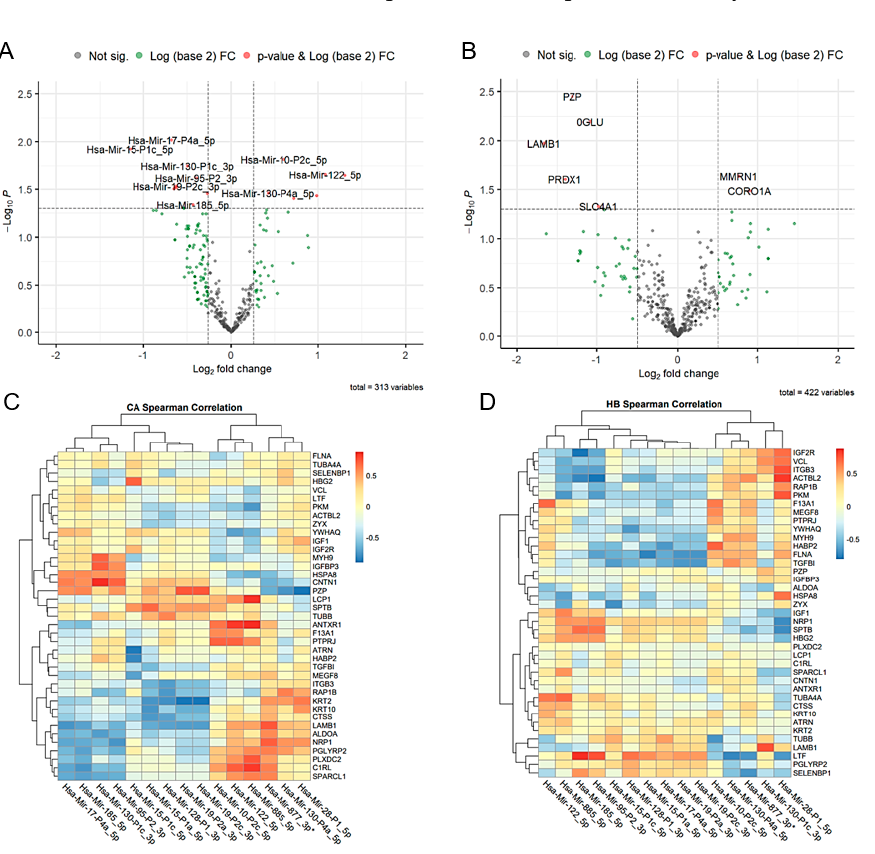
Figure 2. Proteomic data. ( A , B ) Volcano plot of differentially expressed miRNAs ( A ) and proteins ( B ) in CA vs. HB. A total of 15 miRNAs and seven proteins were differentially expressed. ( C , D ) Heatmap of Spearman correlation coefficients between miRNAs and targeted proteins in CA ( C ) and HB ( D ). To detect the proteins involved in cancer development in high-risk benign breast tu- mor, CA and HB samples were subjected to proteomics. Proteomics data analysis in CA and HB detected 422 proteins, and seven proteins were differentially expressed in CA vs. HB. Among the seven proteins, two proteins (MMRN1, CORO1A) were up- and five pro- teins (PZP, SLC4A1, LAMB1, NAGLU, PRDX1) were down-regulated in CA vs. HB (Fig- ure 2B). Moreover, out of the 422 expressed proteins, 72 were identified as targets of 15 differentially expressed miRNAs in CA vs. HB based on miRPath. Spearman correlation between 72 target proteins and 15 differentially expressed miRNAs resulted in 39 proteins having at least one significant association with one of the miRNAs (Supplementary Table S3). In CA, PZP, KRT2, C1RL, LAMB1, and NRP1 were significantly associated with three or more miRNAs, while in HB, FLNA, SPTB, TGFBI, ITGB3, LTF, PKM, and ACTBL2 were